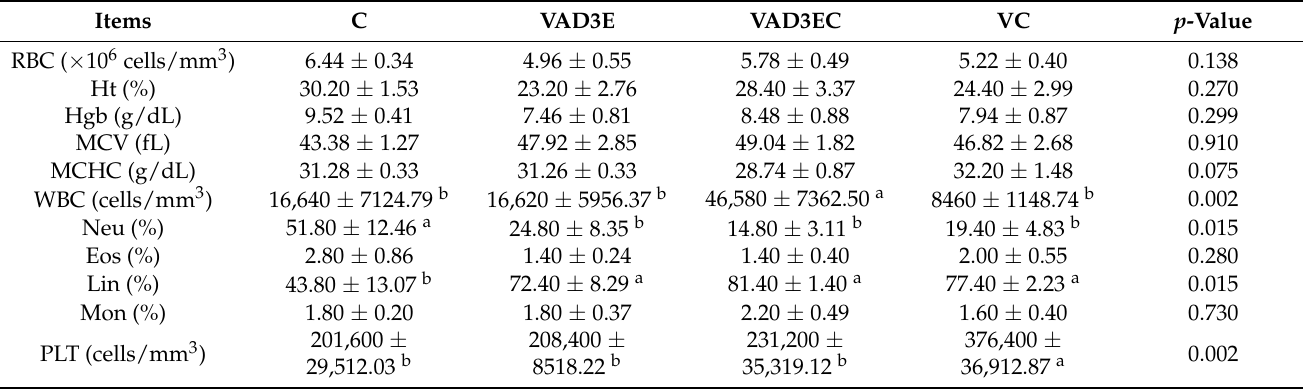
Table 3. Effect of various vitamin on hematology parameters in dairy cows for 14 days.